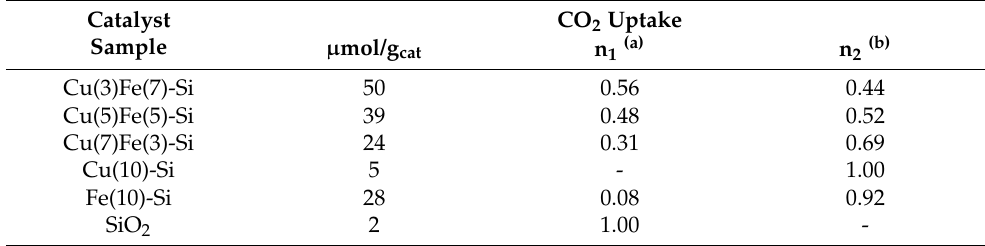
Table 3. Surface properties of the investigated catalyst samples from CO 2 -TPD measurements.